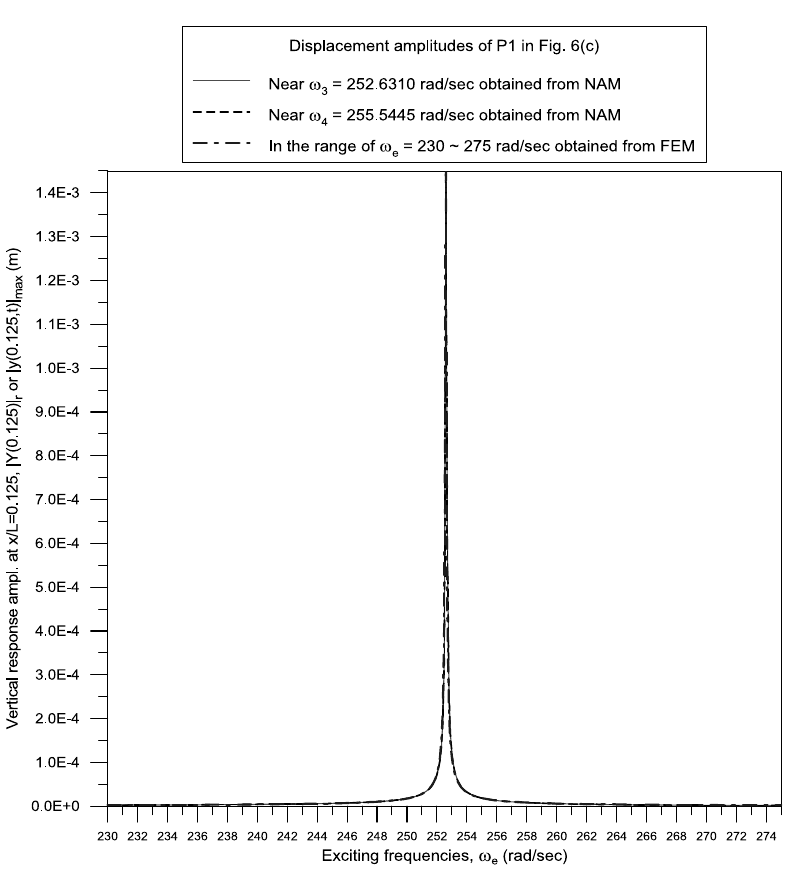
Fig. A.2. The frequency-response curves of point p 1 located at ξ = x / L = 0.125 on the beam shown in Fig. 6(c) (with “zero” initial conditions) near ω 3 = 252.6310 rad/sec obtained from NAM (denoted by −− ), near ω 4 = 255.5445 rad/sec obtained from NAM (denoted by − − − ) and in the range of exciting frequencies ω e = 230 ∼ 275 rad/sec obtained from FEM (denoted by − · − ),